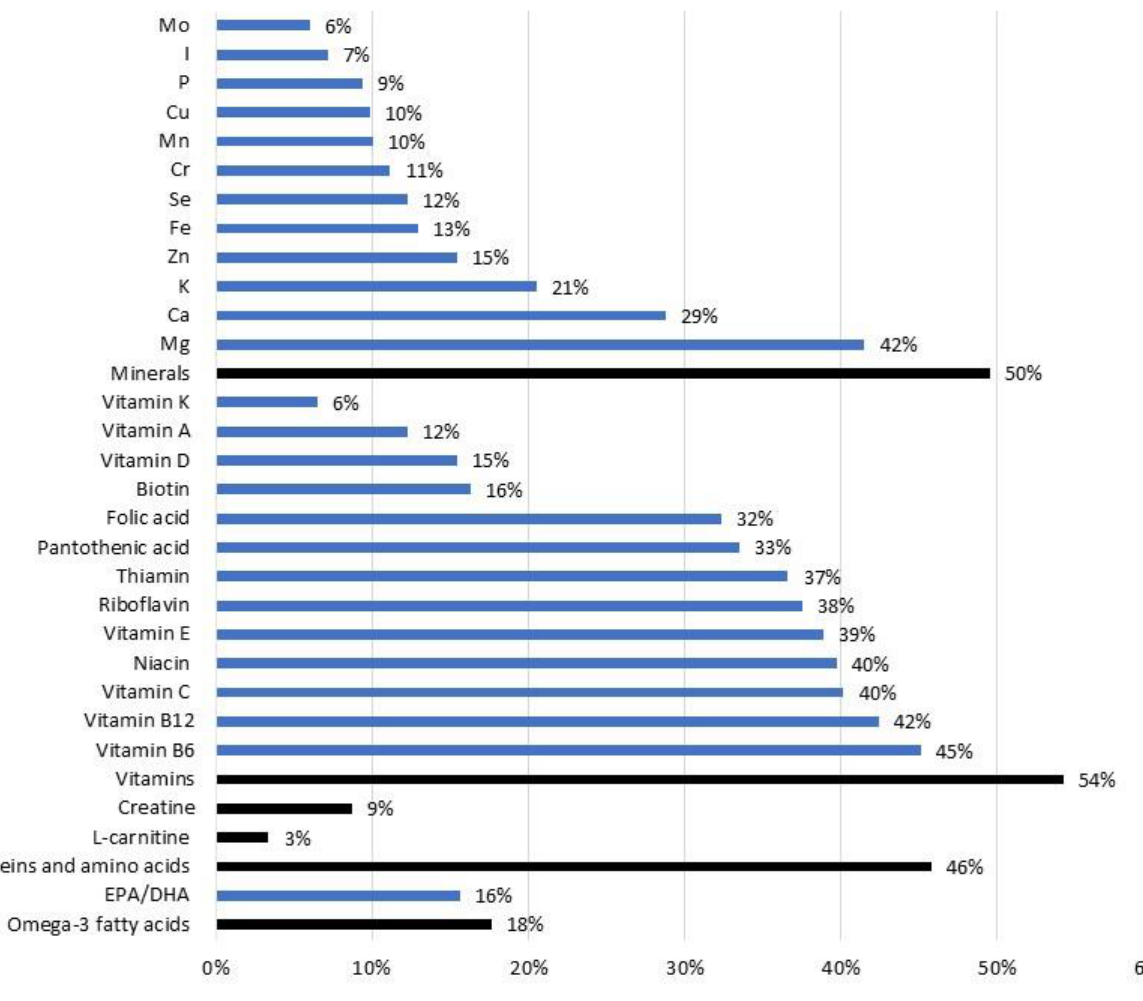
Figure 2. Prevalence of supplementation with specific nutrients and other biologically active ingredients for study participants recruited from the Slovenian Armed Forces during a 12-month period ( n = 448). Note: the black lines indicate specific categories, and the blue lines indicate their subcate- gories.